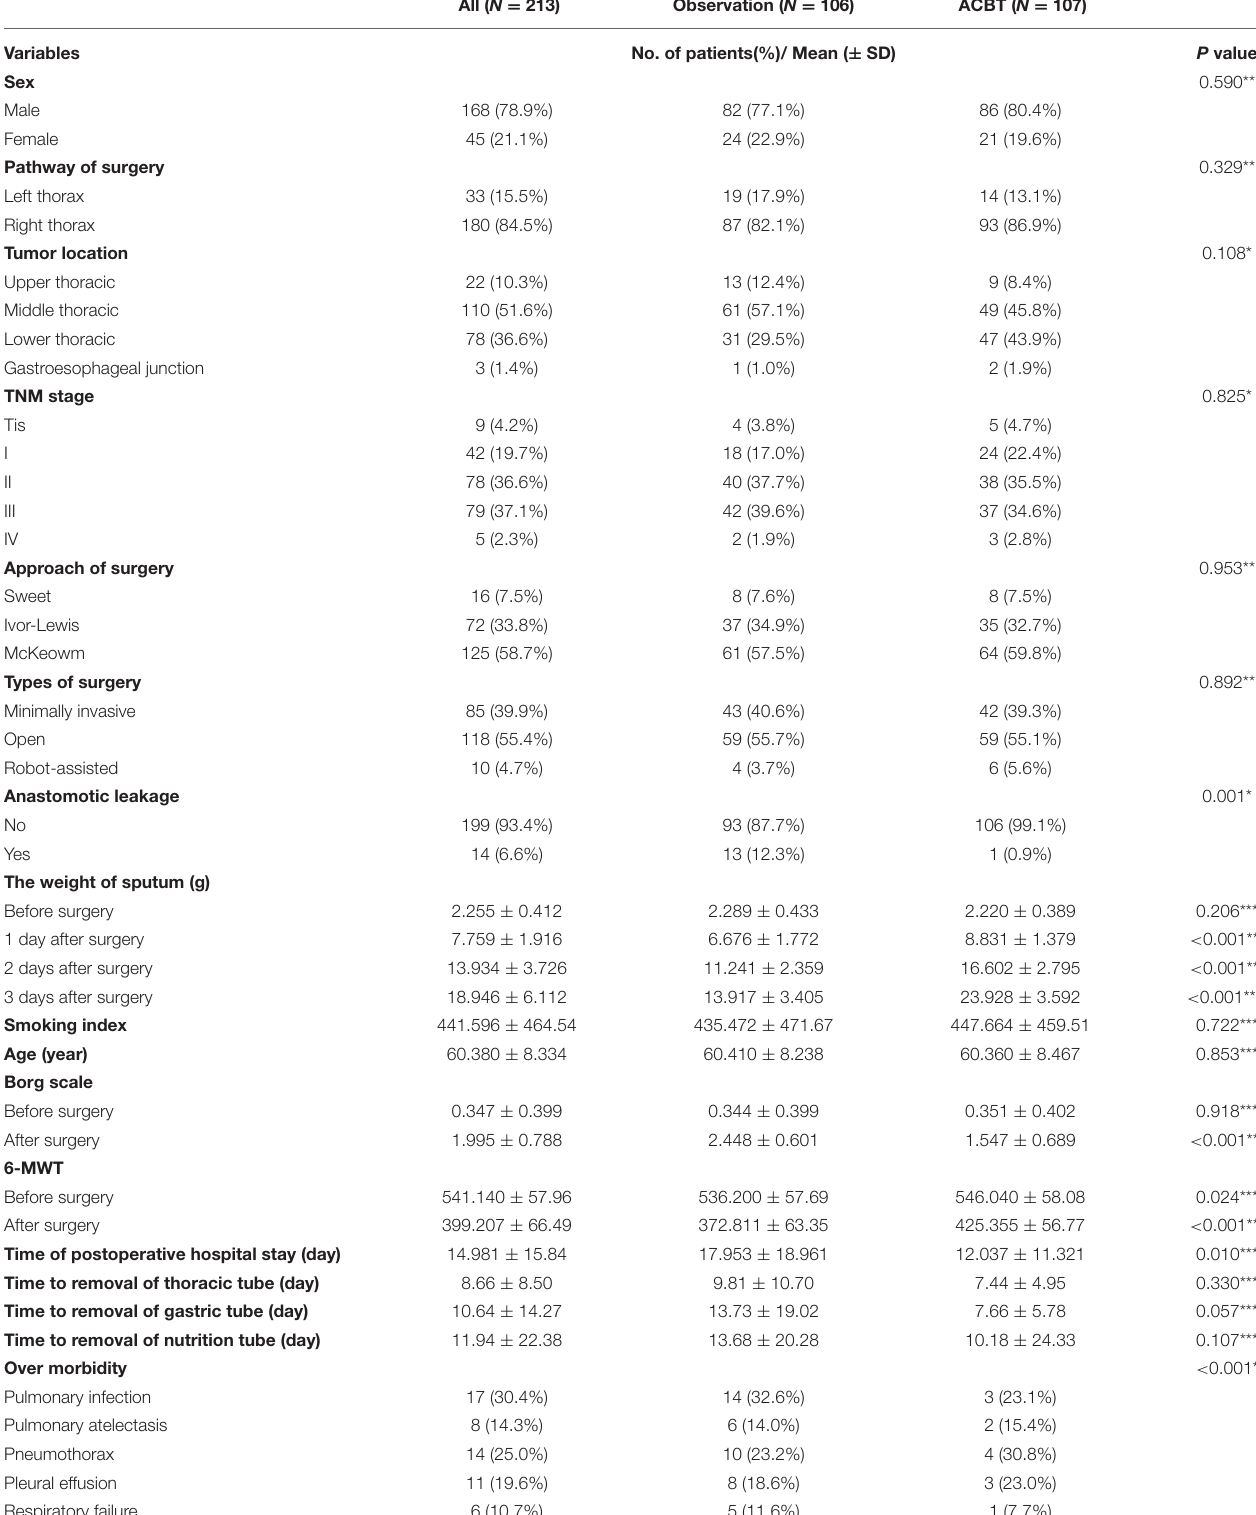
TABLE 1 | The associations of clinicopathological characteristics in the groups of observation and